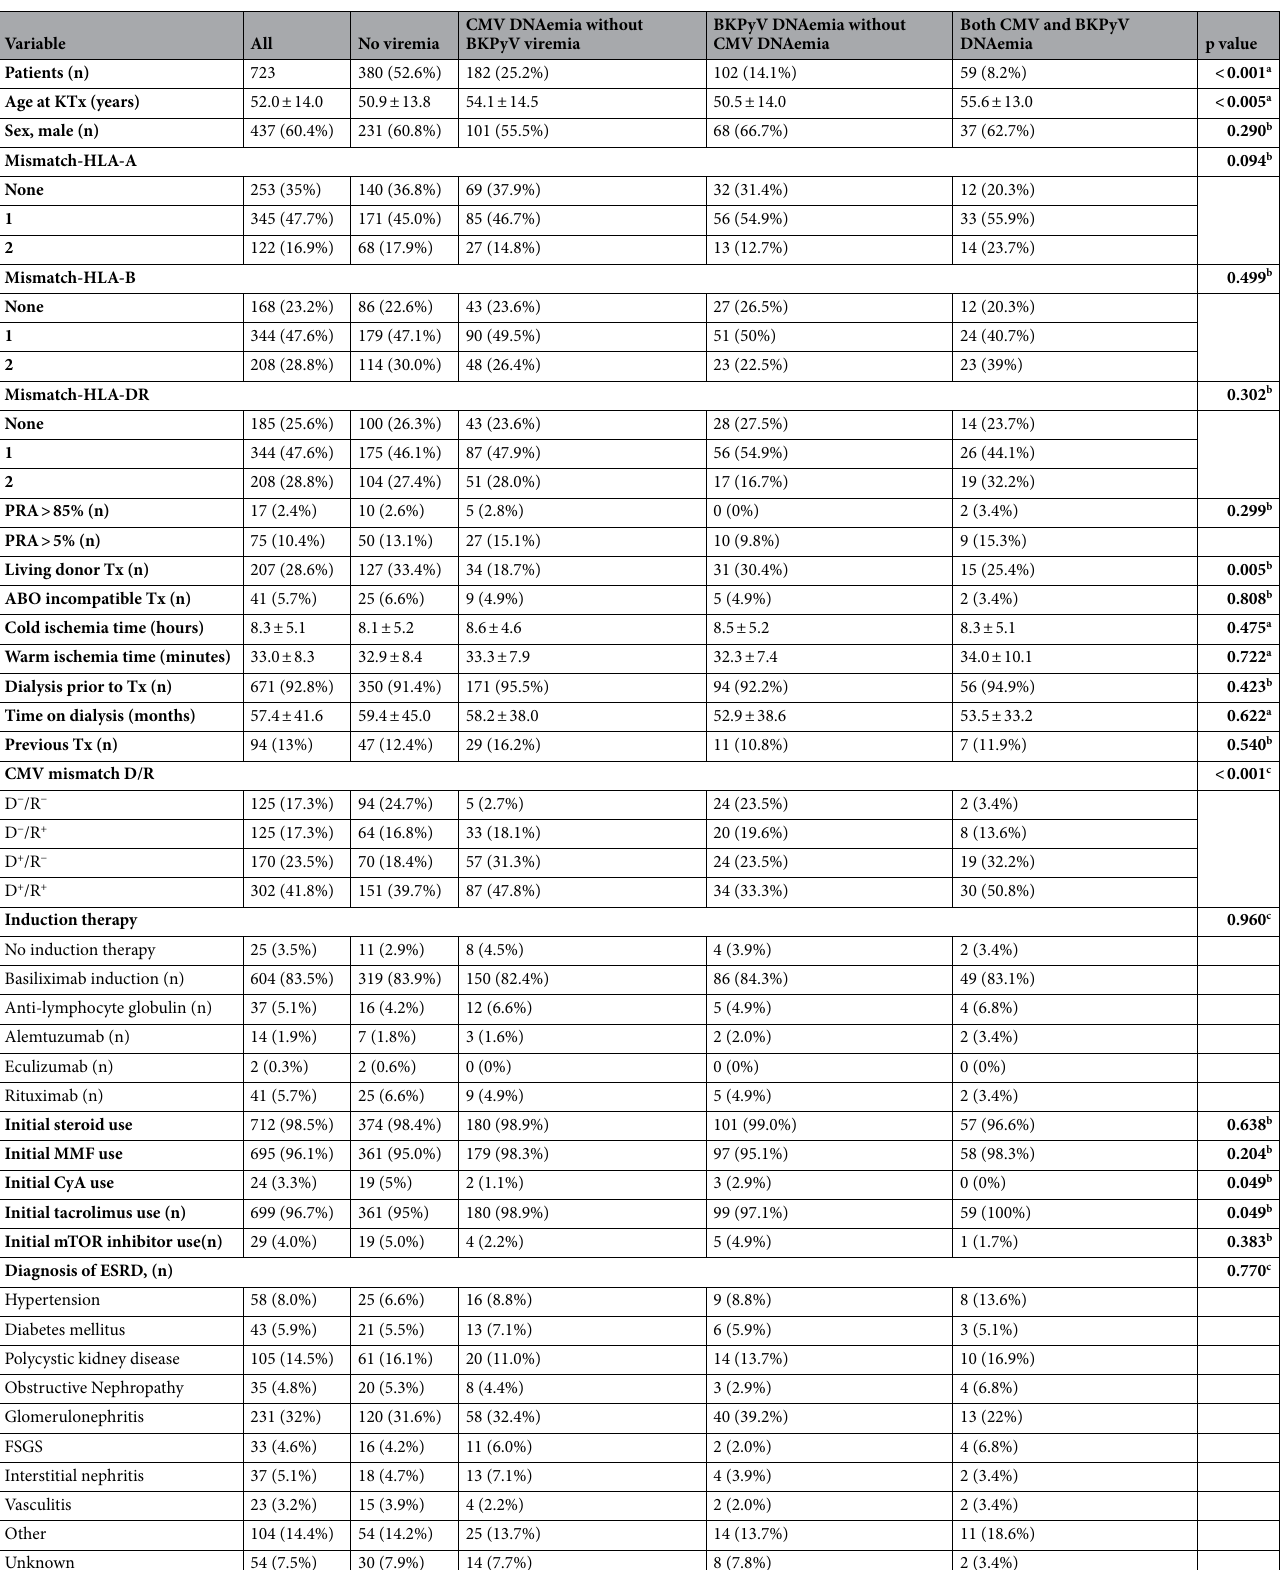
Table 1. Patients’ demographic and clinical characteristics at transplantation. CMV cytomegalovirus; Tx transplantation, HLA human leukocyte antigen, PRA panel reactive antibodies, MMF mycophenolate